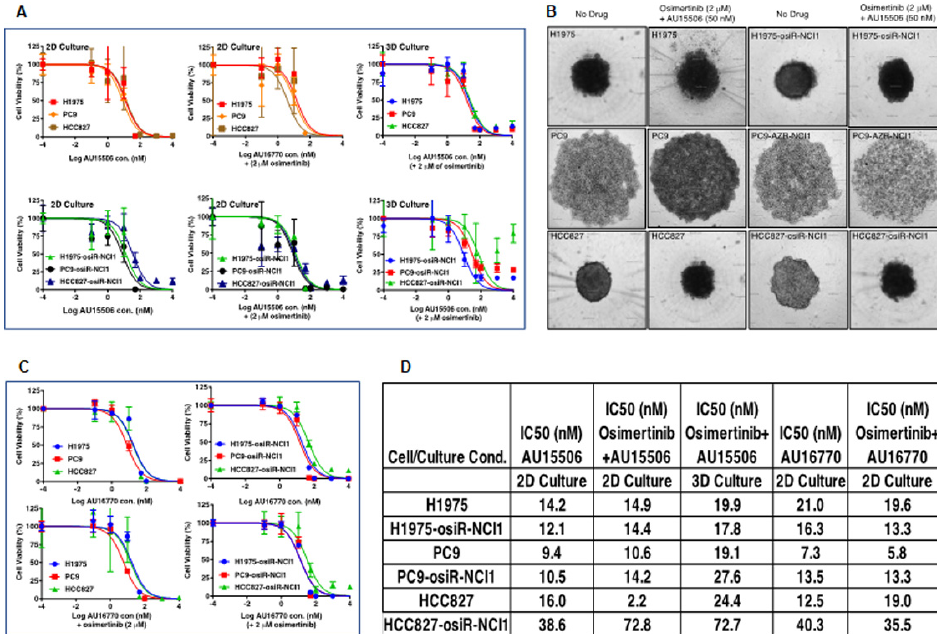
Figure 3. CDK12 inhibitors, AU-15506 and AU-16770, inhibit growth of osimertinib-sensitive and -resistant cell lines. H1975/H1975-osiR-NCI1, PC9/PC9-osiR-NCI1, and HCC827/HCC827-osiR-NCI1 were either grown in flat-bottom (2D culture, ( A )-left and middle panels) or specially designed round- bottom (3D sphere culture, ( A )-right panels, and ( B )) 96-well plates, and were then treated with AU-15506, AU-15506-osimertinib ( A , B ), AU-16770, or AU-16770-osimertinib ( C ) as indicated for 3 days before cell viability measurements. AU-15506 or AU-16770 either alone or in combination with osimertinib inhibited cell growth as indicated by lower IC50s ( D